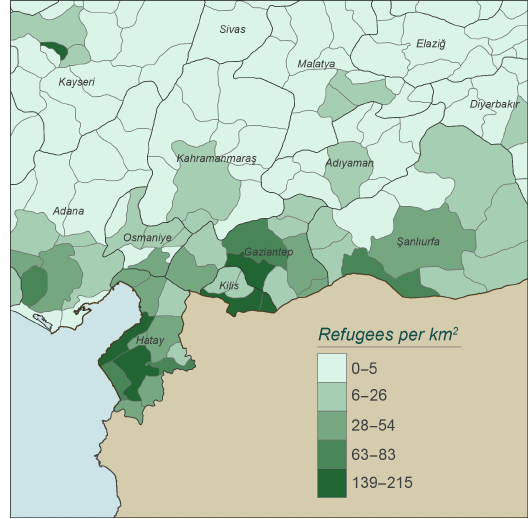
Figure 2. Migrated population density, December